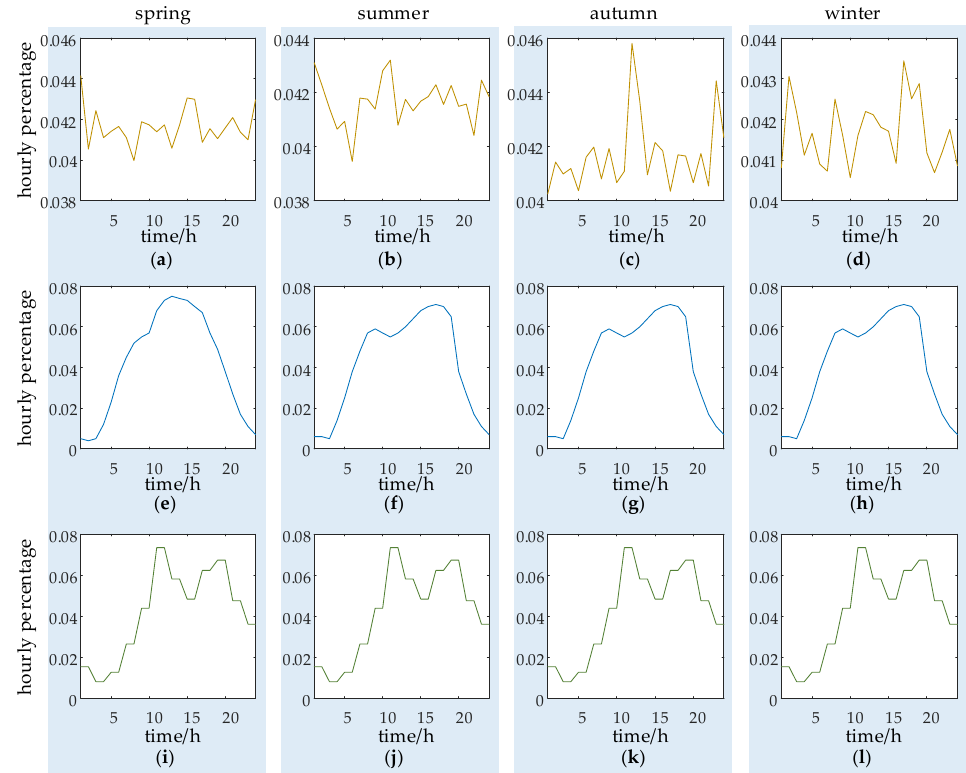
Figure 5. Hourly percentage of hydrogen load in different area for four seasons. ( a – d ) industrial hydrogen load; ( e – h ) traffic hydrogen load; ( i – l ) hydrogen load for heating. The annual electrical load forecast for the region is shown in Figure 6. Based on the maximum load for each month from 2018 to 2021, a typical day can be selected from each of January, April, July, and November, and the load curve is shown in Figure 7.